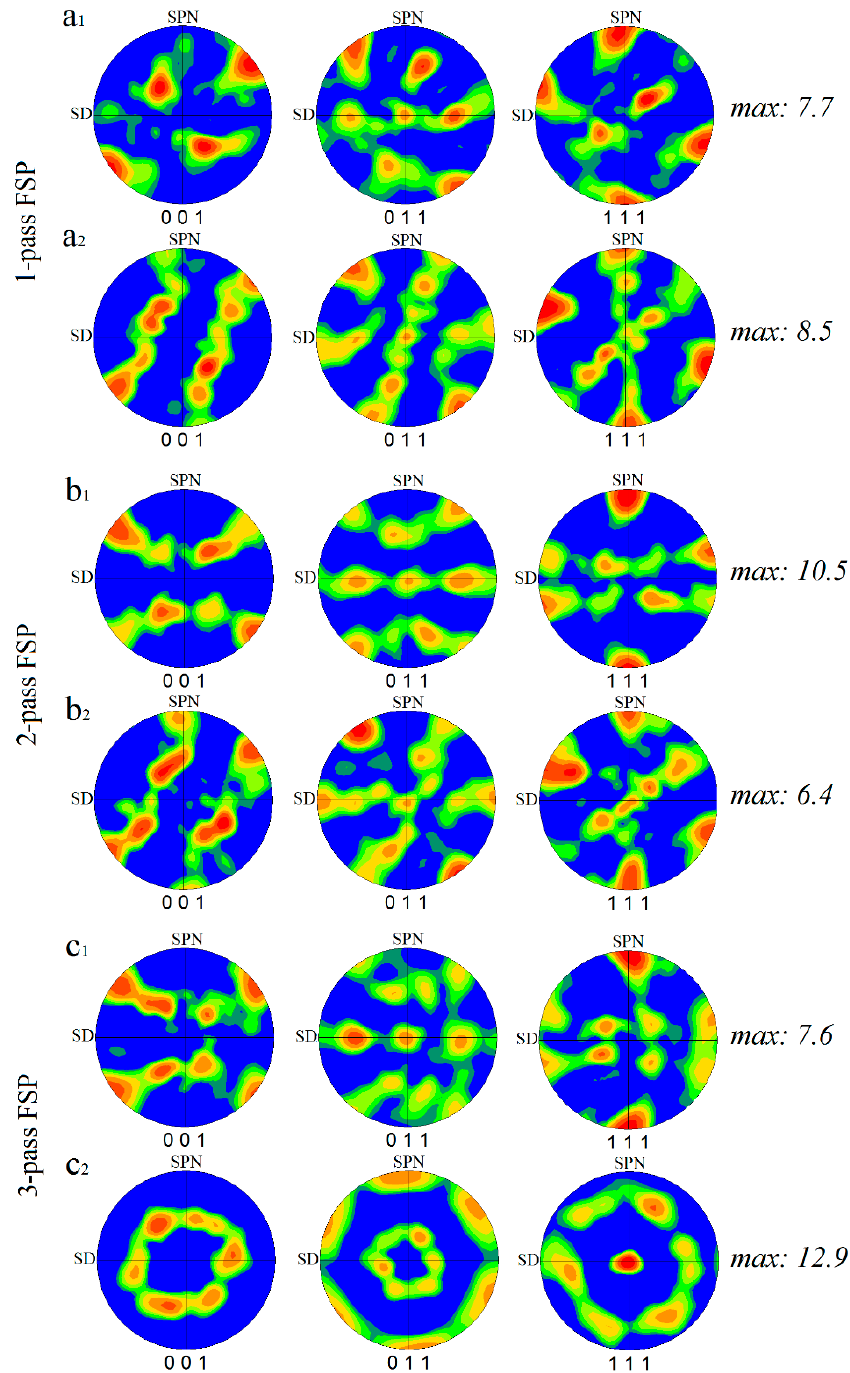
Figure 16. Rotated (001), (011), and (111) pole figures of SZ-I and SZ-II areas in ( a ) 1-pass, ( b ) 2-pass, and ( c ) 3-pass FSPed samples, respectively: ( a1 , b1 , c1 ) SZ-I and ( a2 , b2 , c2 ) SZ-II. The texture intensity values are written at the right-hand side of PFs.